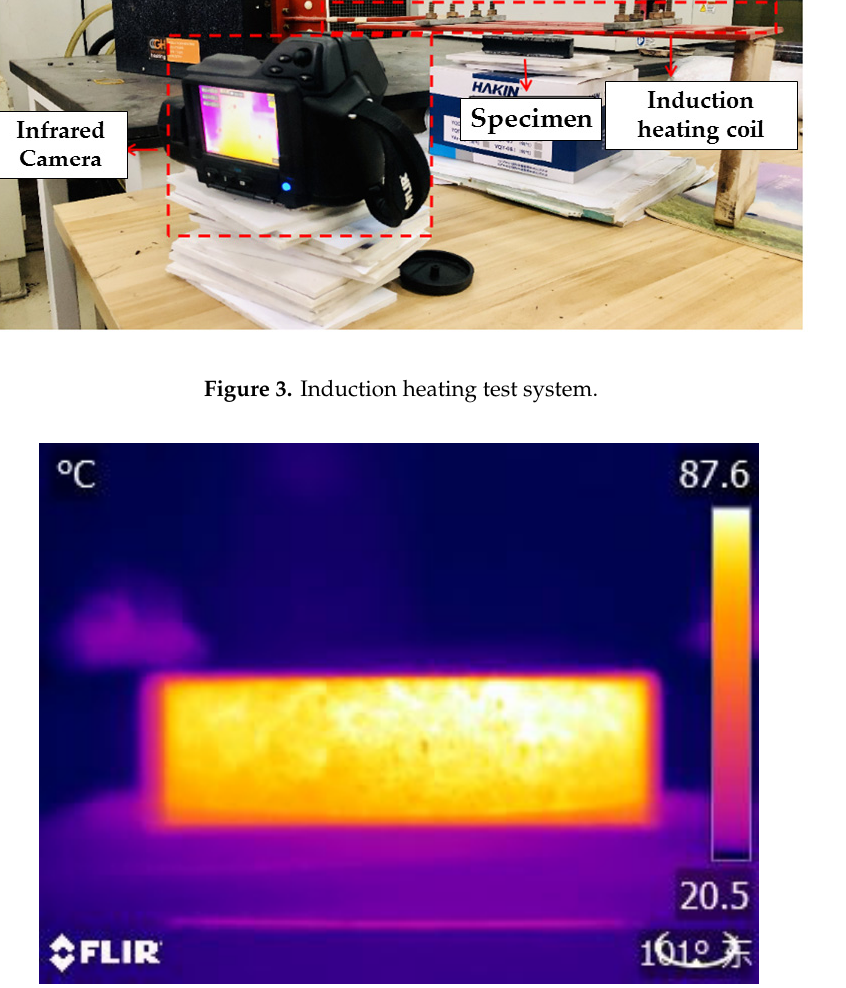
Figure 4 Infrared image of sample exposed to induction heating.